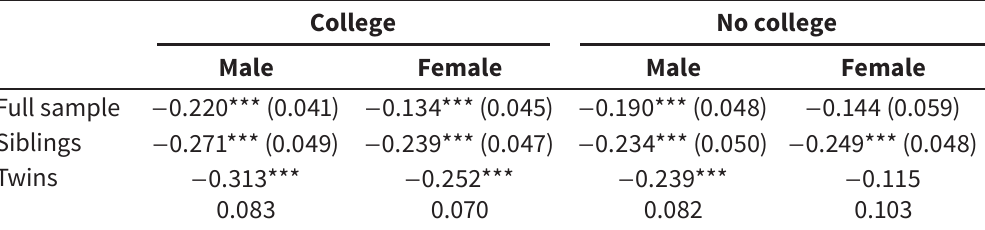
The effect of smoking on earnings by gender and